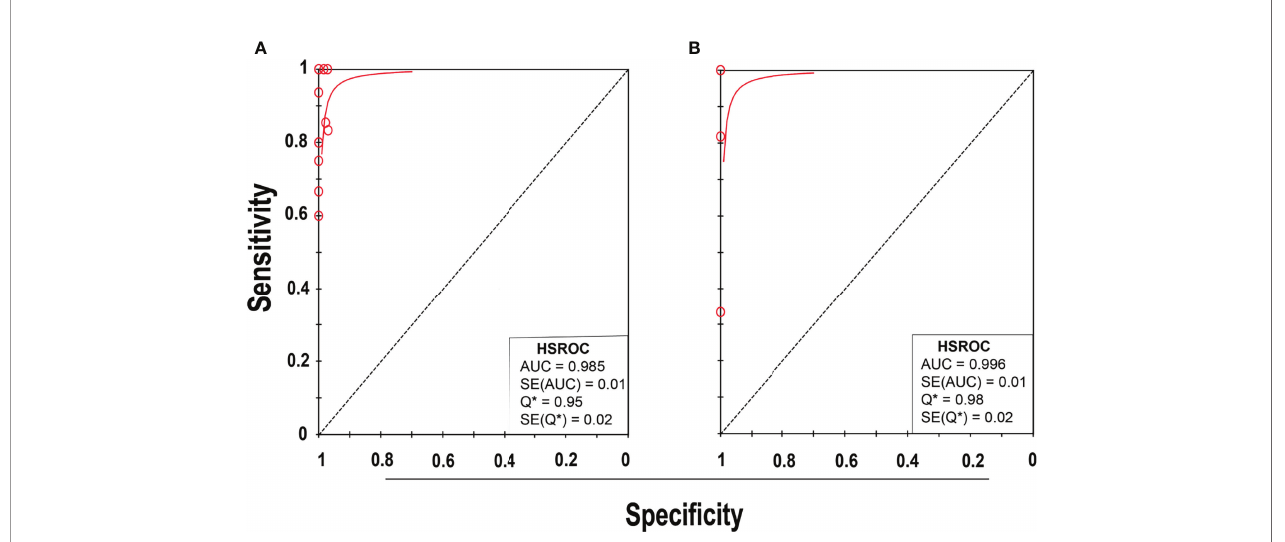
FIGURE 4 | SROC plot of NAAT for (A) MSSA and (B) MRSA detection. Red circles represent each investigation ’ s data point, while the solid blue line shows the SROC curve.